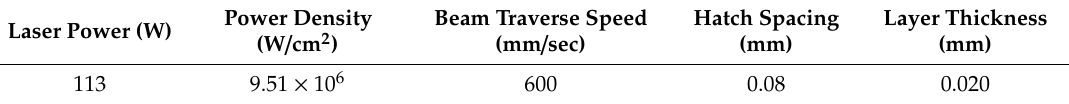
Table 1. The laser powder bed fusion (L-PBF) process